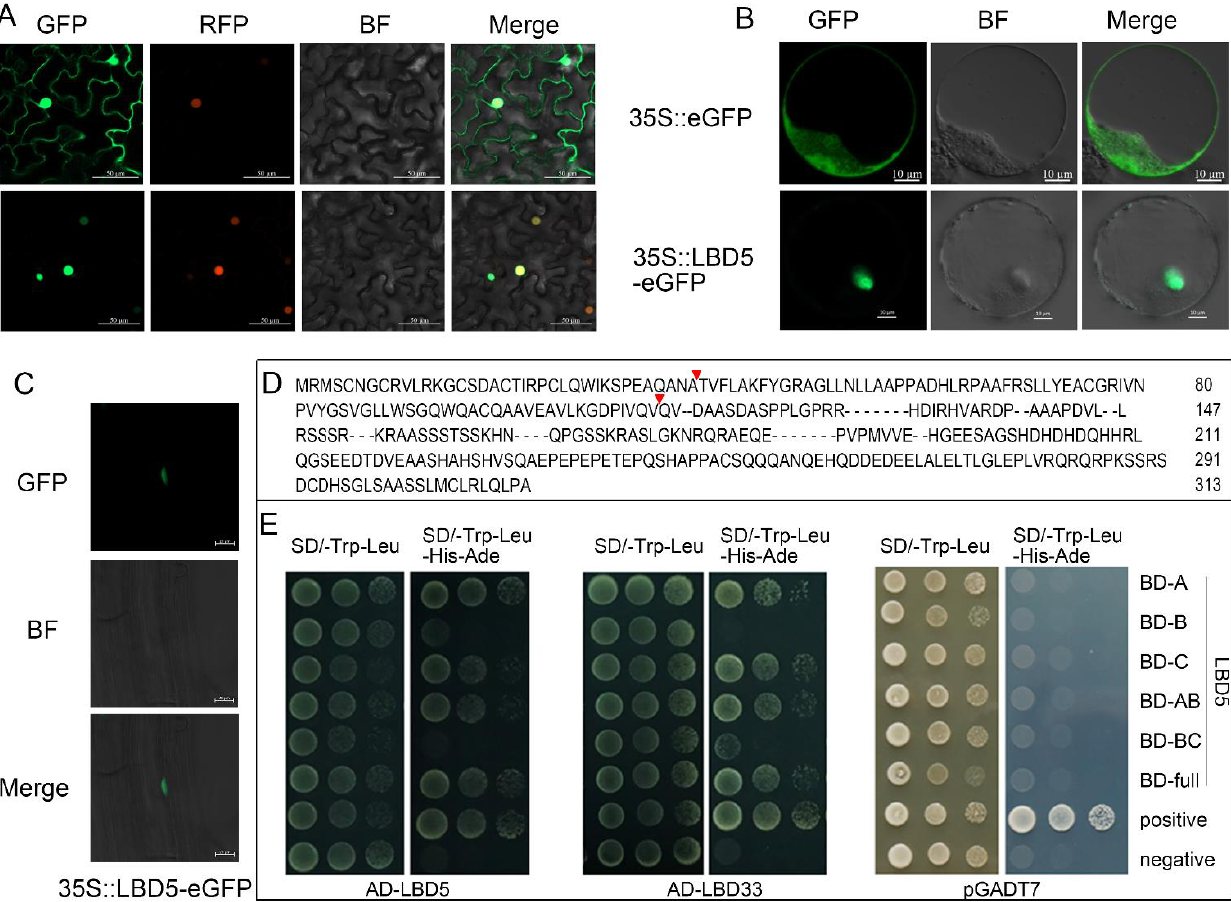
Figure 2. Subcellular localization and dimer-forming ability of ZmLBD5: ( A – C ) Subcellular locali- zation of ZmLBD5 in tobacco leaves, maize protoplasts, and 35S::ZmLBD5-eGFP transgenic Arabidopsis, respectively (bar = 50, 10, and 20 μm , respectively). ( D ) Three fragments of ZmLBD5 ( A – C ) were divided and the red triangle indicated the position of truncation. ( E ) The ability of ZmLBD5 to form dimers in the yeast strain Y2H Gold. The Y2H Gold strains containing target plasmids were diluted and cultured on no-selection synthetic dropout (SD) media without tryptophan and leucine (SD/-T-L), or on selection SD media without tryptophan, leucine, histidine, and adenine (SD/-T-L-H-A). Photos were taken 3 days after inoculation for the plates. Fragments A, B, and C represent CX2CX6CX3C, GAS, and LX6LX3LX6L, and various C-terminal domains, respectively.